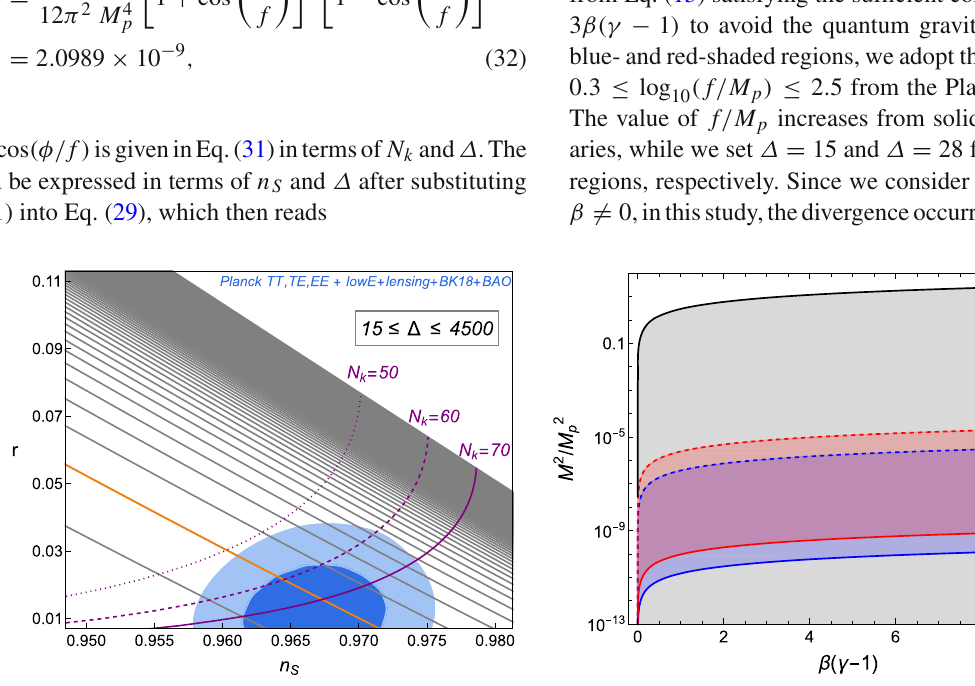
M 2 / M 2 p from Eq. (24), where the black line corresponds to the cutoff scale M 2 / M 2 p = 3 β(γ − 1 ) . The gray shaded region is the allowed parameter space satisfying M 2 / M 2 p (cid:4) 3 β(γ − 1 ) . For the blue- and red-shaded regions, we set Δ = 15 and Δ = 28, respectively, and vary the f / M p value within the range of 0 . 3 ≤ log 10 ( f / M p ) ≤ 2 . 5 adopted from Planck paper [10,11], the value increases from solid to dashed